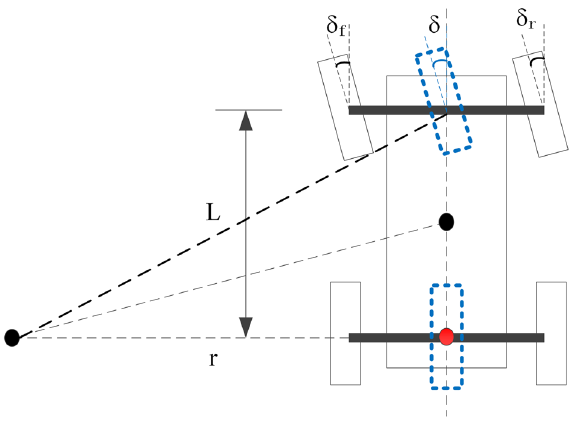
Figure 8. Ackerman steering geometry diagram.